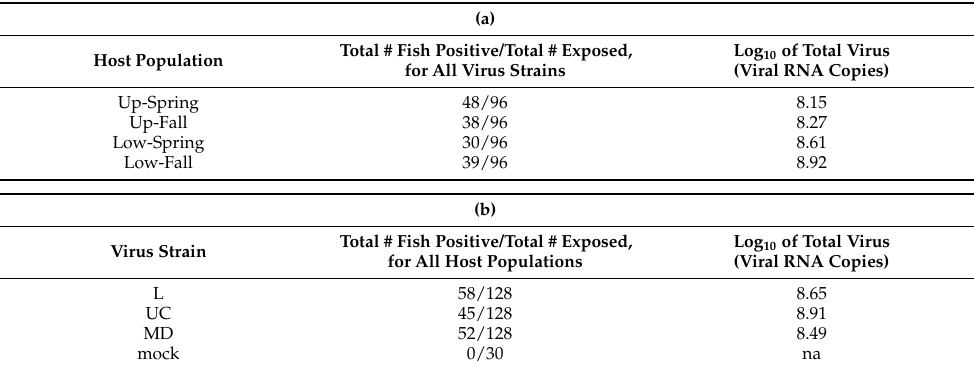
Table 2. Summary of juvenile Chinook salmon infection frequencies and total log 10 viral loads three days after exposure to IHNV. ( a ) Data for each host population are combined totals from all three virus strains, for all virus exposure doses. ( b ) Data for each virus strain are combined totals from all four host populations, for all virus exposure doses.